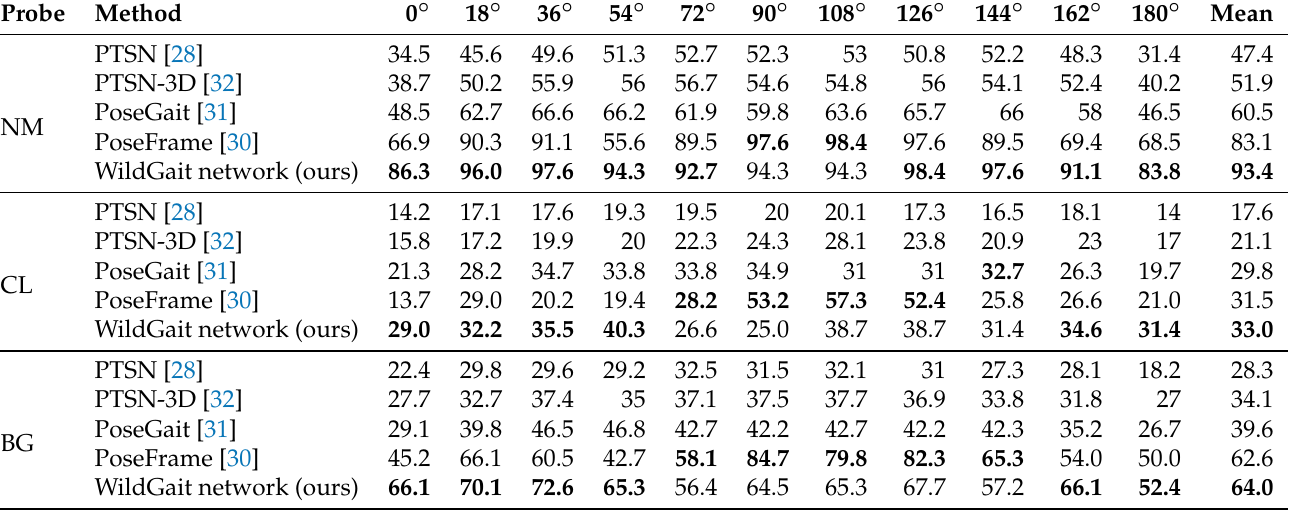
Table 5. Comparison with other skeleton-based gait recognition methods on CASIA-B dataset. In all methods the gallery set contains all viewpoints except the proble angle. WildGait achieves state-of-the art results in normal walking (NM) and carry-bag variation (CB) by a large margin, being able to generalize well across camera viewpoints. We highlight with bold our network (WildGait) and best results in each walking